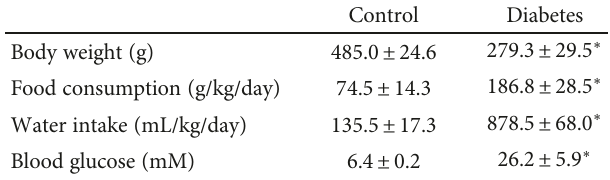
Table 1: General characteristics in control and diabetic